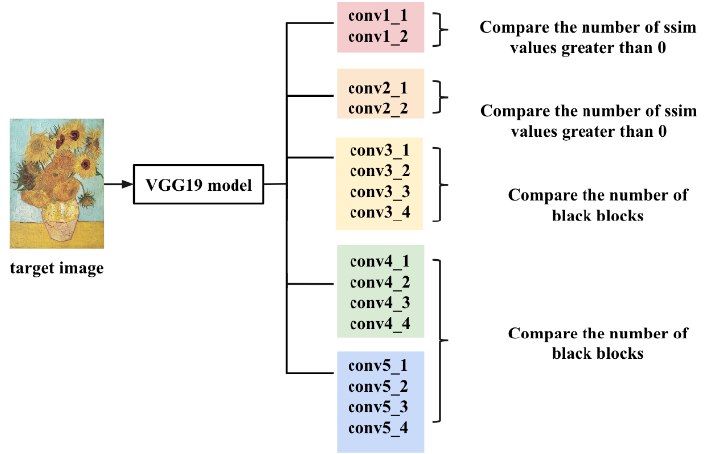
Figure 7. Architecture of the number of layers selected for the target image.